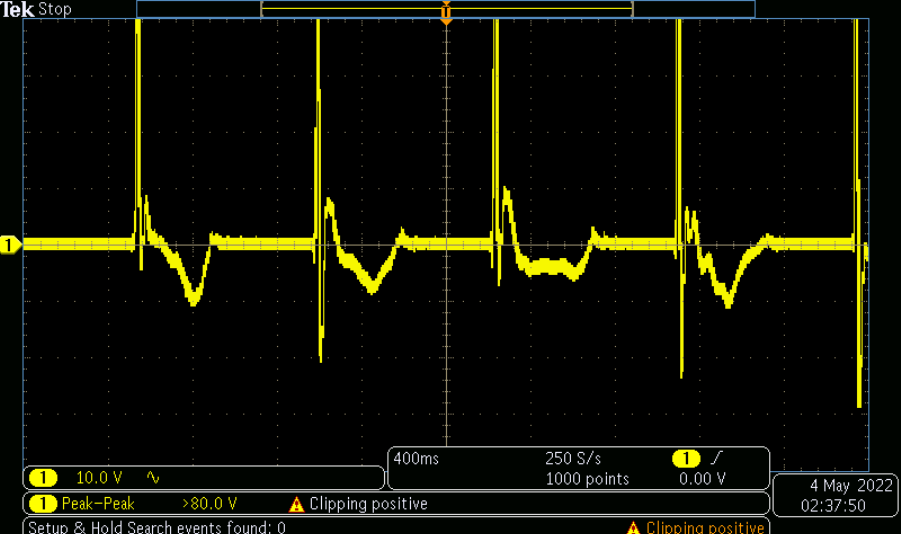
Figure 6. Output voltage under stomping motion.